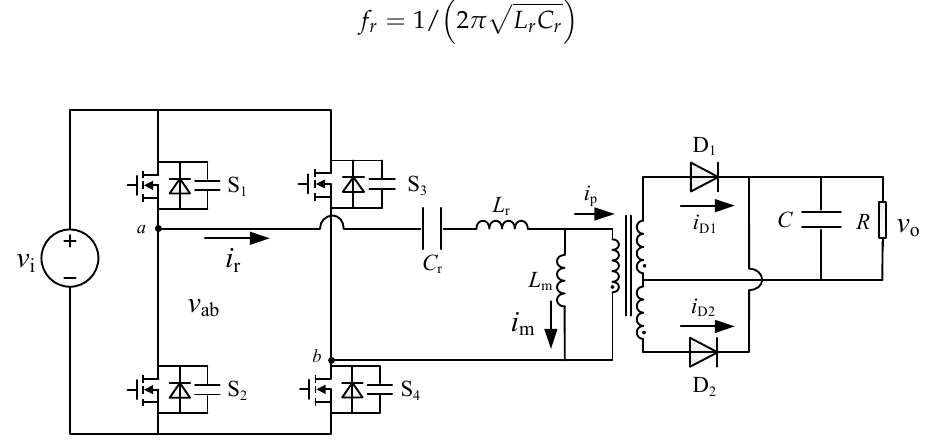
Figure 1. Circuit block diagram of LLC resonant converter.